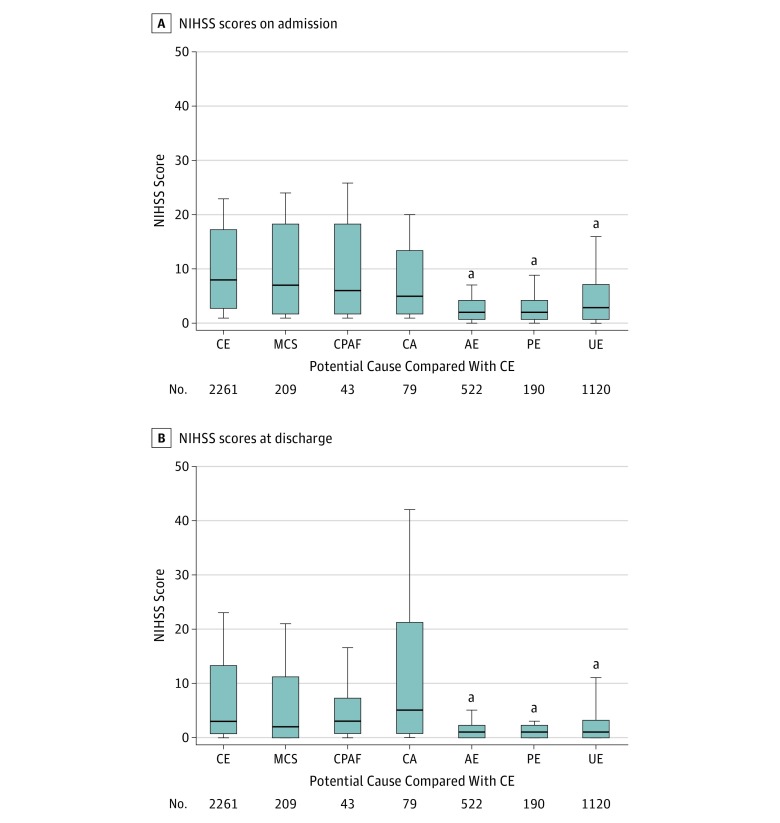
Neurological SeverityThe National Institutes of Health Stroke Scale (NIHSS) scores on admission (A) and at discharge (B) are shown according to each potential cause compared with cardioembolic stroke (CE). The NIHSS score can range from 1 to 42 and measures neurological severity categorized into 3 clinically meaningful groups (mild if 0-4, moderate if 5-14, and severe if ≥15). In patients who died during hospitalization, the NIHSS score at discharge was assigned the maximum score of 42. The box indicates ranges between lower quartile score and upper quartile score, and the horizontal line in the box represents the median score. Lower and upper vertical bars indicate the 10th and 90th percentiles, respectively. AE indicates arteriogenic emboli; CA, cancer associated; CPAF, covert paroxysmal atrial fibrillation; MCS, minor-risk potential cardioembolic sources; PE, paradoxical embolism; and UE, undetermined embolism.aStatistically significant at P < .05 vs CE by multiple comparisons.